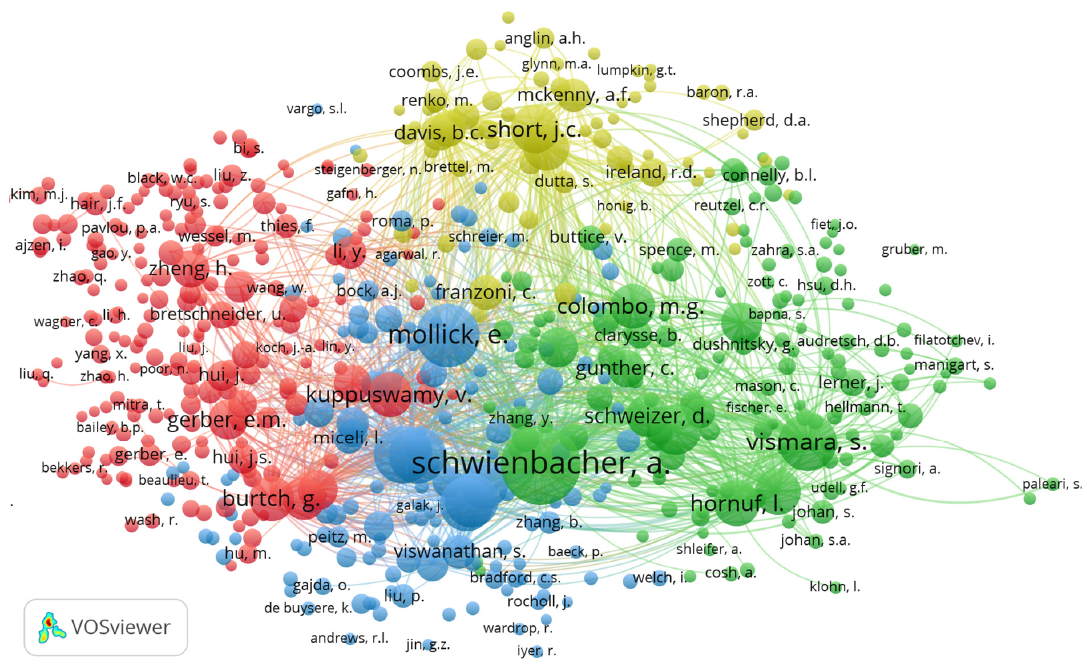
Figure 9. Co-citation analysis of